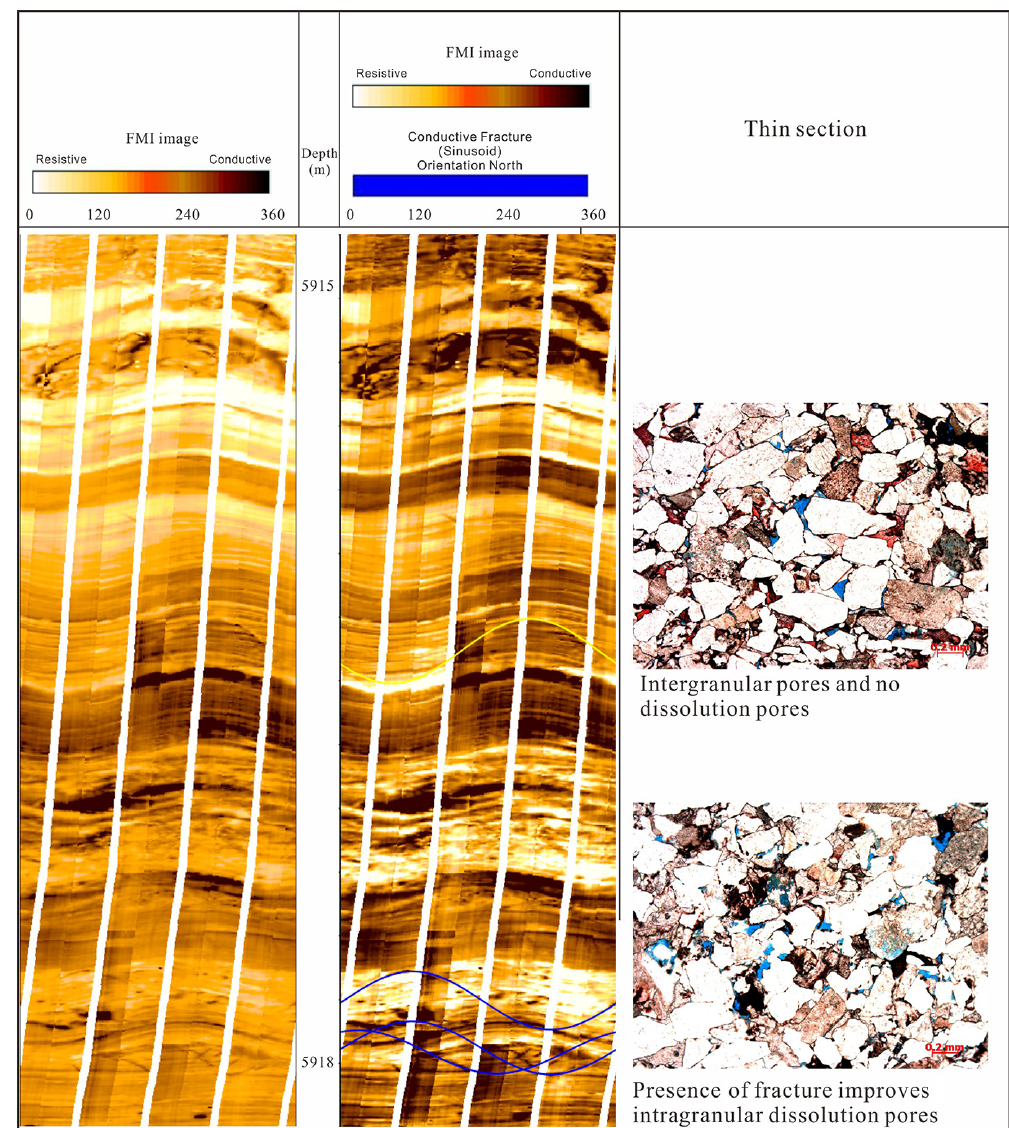
Figure 19. Dissolution pores are mainly associated with fractures, and no evident dissolution pores in layers without fractures (Dabei